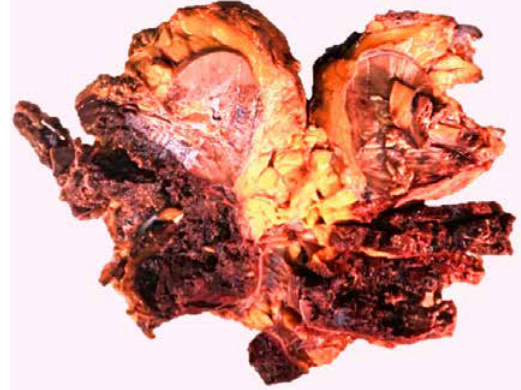
Figure 2 : Operative specimen